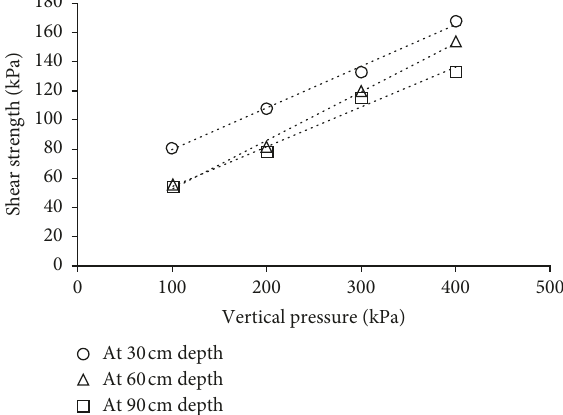
Figure 13: Shear strengths at different